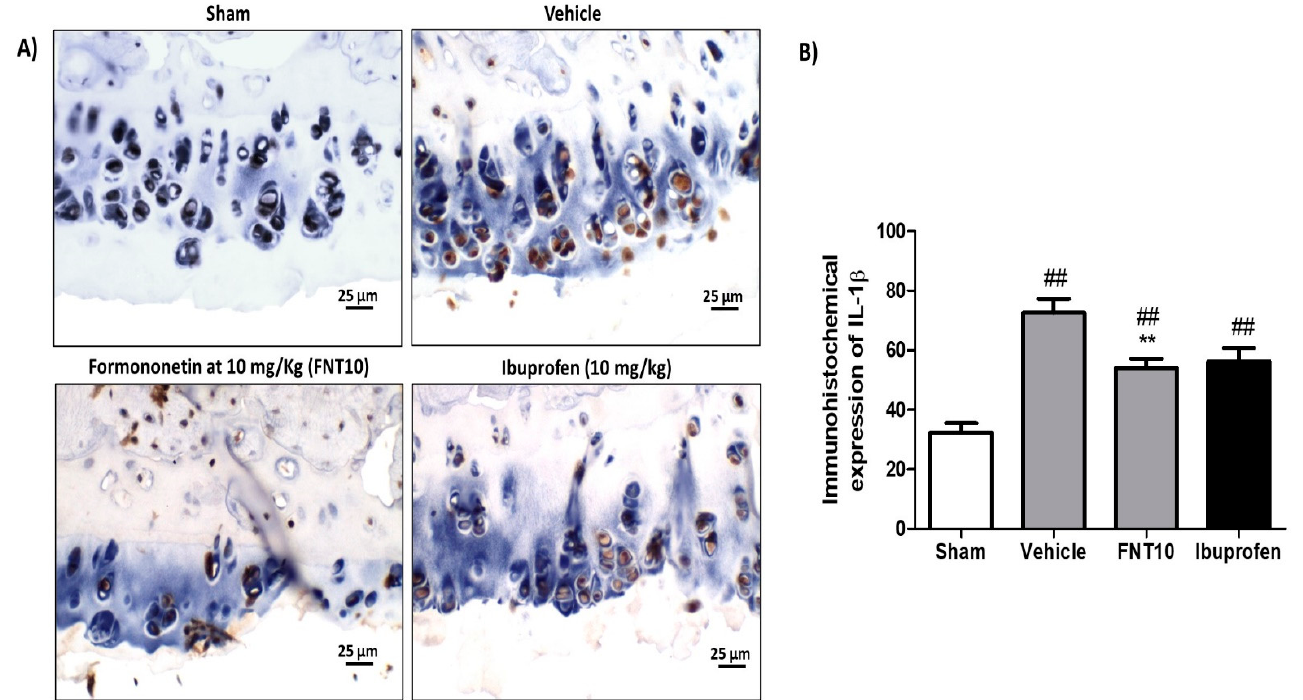
Figure 3. ( A ) Immunohistochemical expression pattern of cell positivity for IL-1 β in the experimental groups treated with oral administration of vehicle only (Vehicle), formononetin at 10 mg/kg (FNT), and ibuprofen at 10 mg/kg (LSAB, 400 × ). ( B ) Assessment of the mean number of IL-1 β -positive cells for histological field (0.025 mm 2 ). Differences in comparison with Vehicle are expressed as ** p < 0.01, whereas differences in comparison with Sham are expressed as ## p < 0.011 (ANOVA and Bonferroni’s multiplex comparison